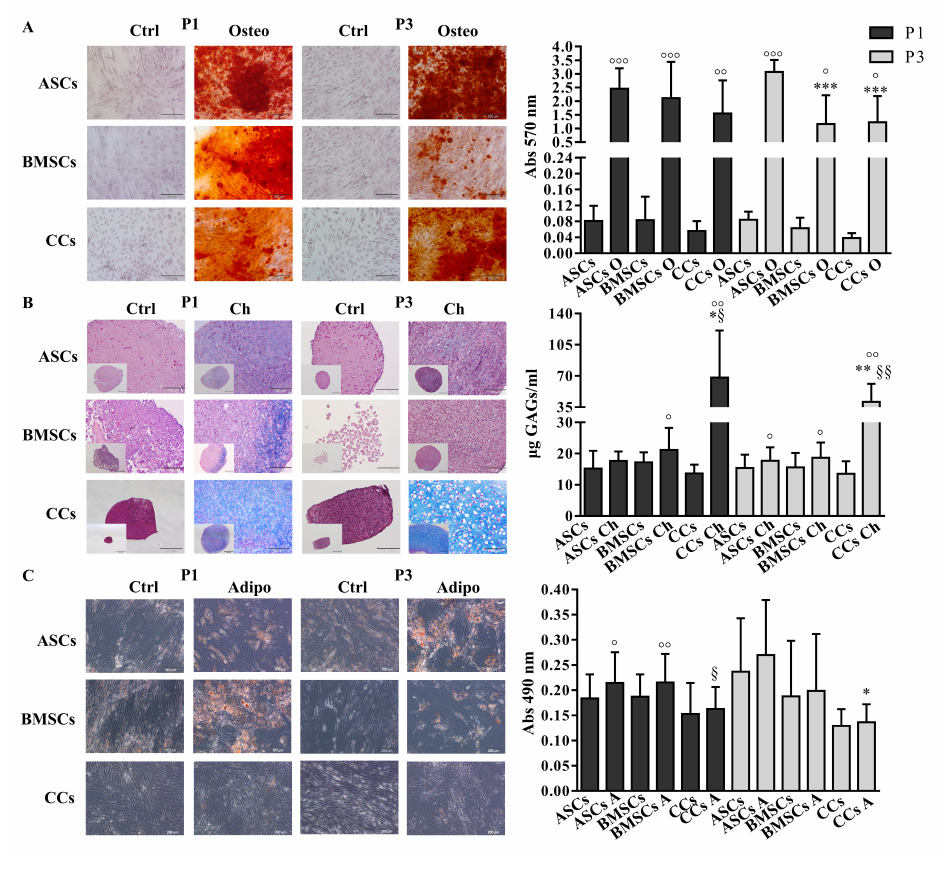
Figure 2. Multi-differentiation potential. ( A ) Osteogenic-O (Alizarin red staining), ( B ) Chondrogenic-Ch (Alcian blue staining and GAG quantification), and ( C ) Adipogenic-A (Oil O